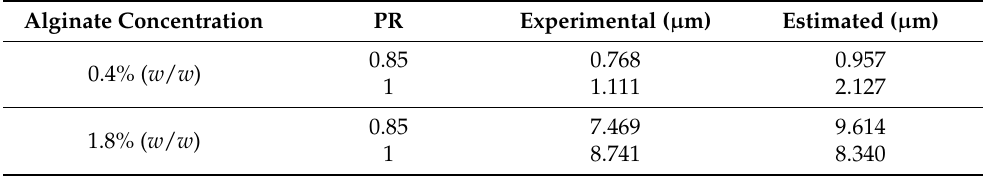
Table 8. Results of consistency